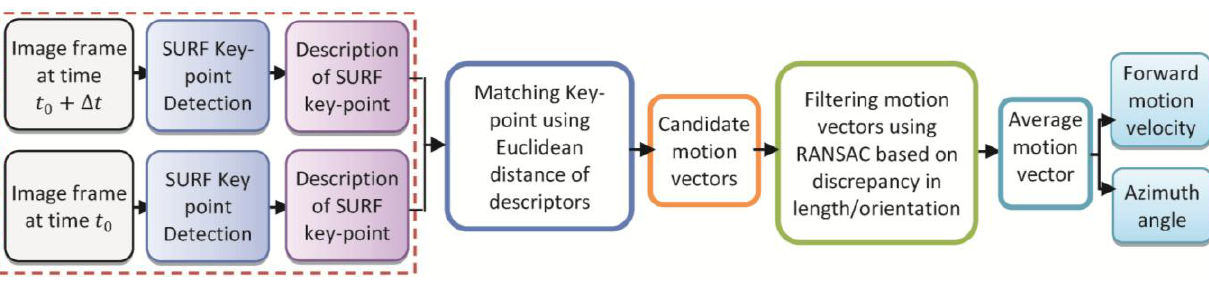
Figure 11. Flow-chart of the computer vision